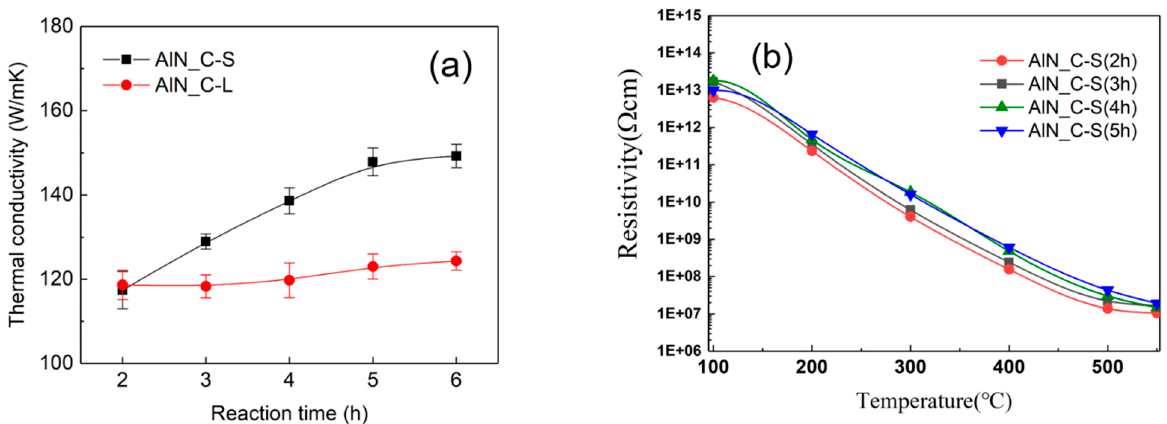
Figure 5. ( a ) Thermal conductivity of sintered AlN_C-S and AlN_C-L materials. AlN_C-S with smaller oxygen level and grain size exhibits more thermal conductivity than AlN_C-L. However, commercial materials without 4-coordinated AlN 3 O sites shows more thermal conductivity (160 W/mK) than AlN_C-S despite having almost the same oxygen content. ( b ) High-voltage electrical resistivity of sintered samples of AlN_C-S materials (100 V/mm). As carbothermal reaction time increases, electrical resistivity increases as a result of reduced carrier, aluminum vacancy (V Al ).